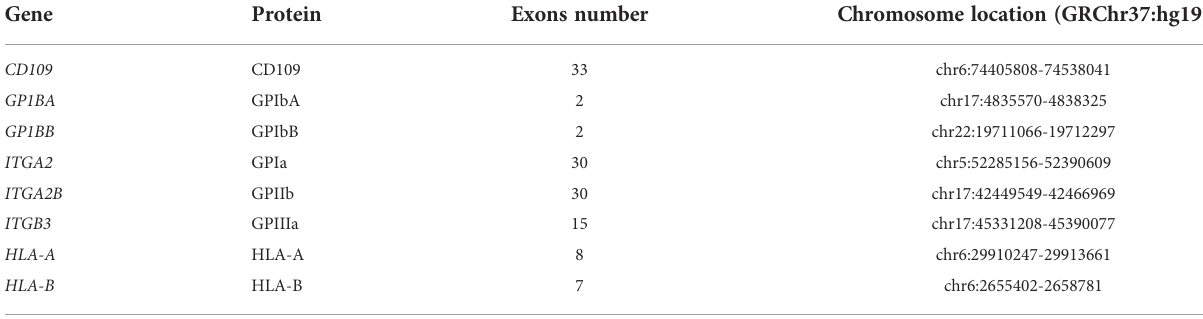
TABLE 1 The information on covered region in the gene for HPA and HLA-A and HLA-B genotyping.